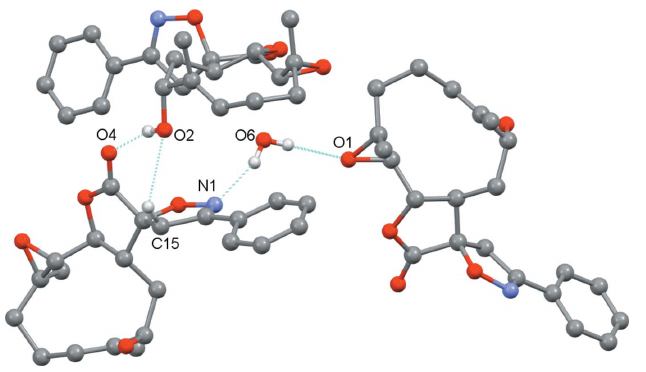
Figure 2 A fragment of the title structure, showing molecules connected by hydrogen bonds (dashed cyan lines).